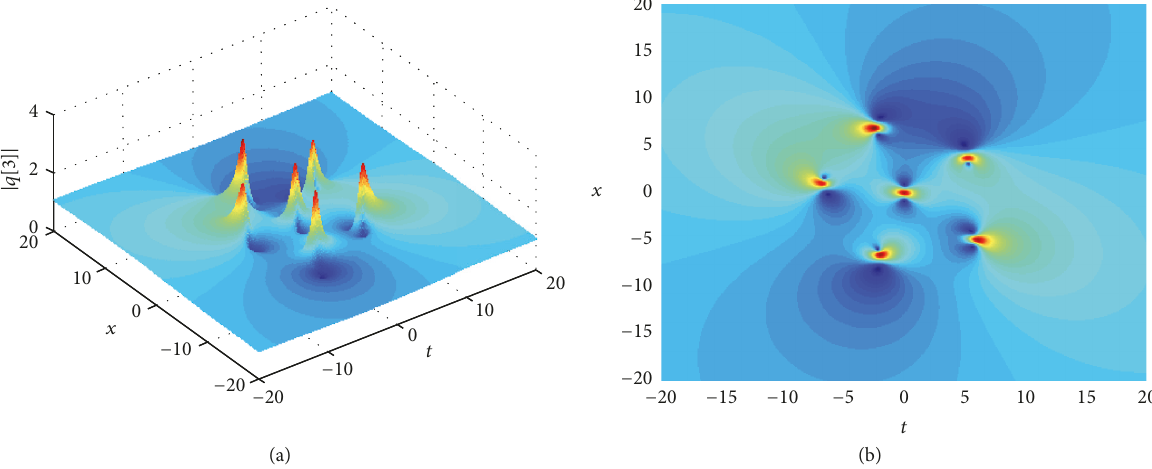
Figure 7: (a) The third-order rogue wave with 𝜀 = 0.02 and 𝑏 2 = 1500 ; (b) the density plot with 𝜀 = 0.02 and 𝑏 2 = 1500 .